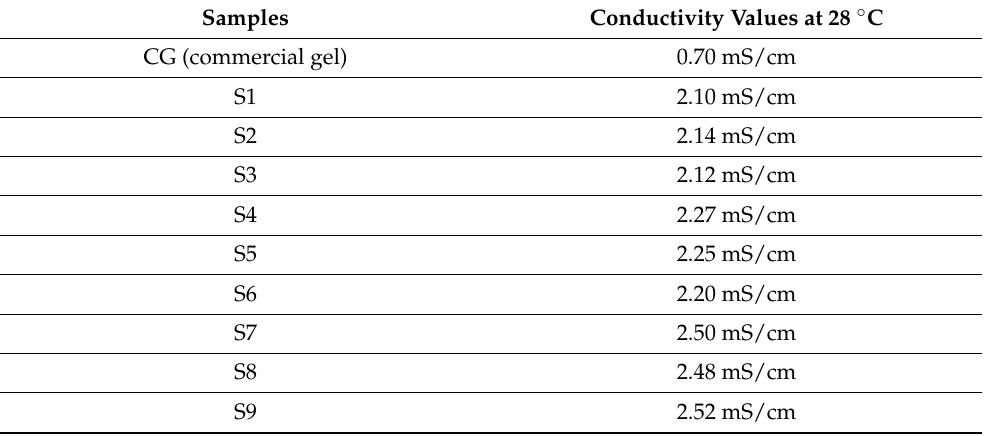
Table 2. Conductivity values of prepared ultrasound gel formulations and commercial ultrasound gel.